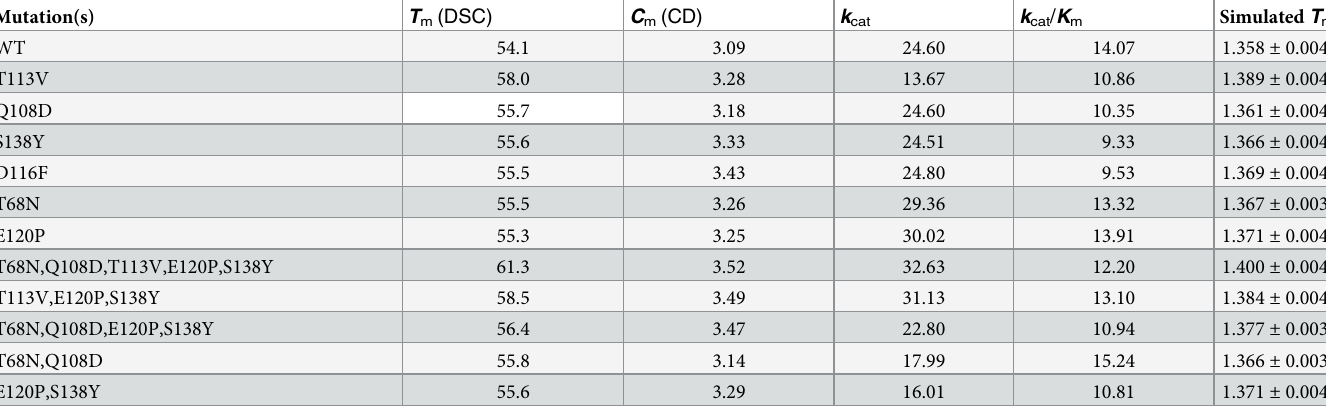
Table 1. The simulated and experimental results of the selected single point mutants and WT.